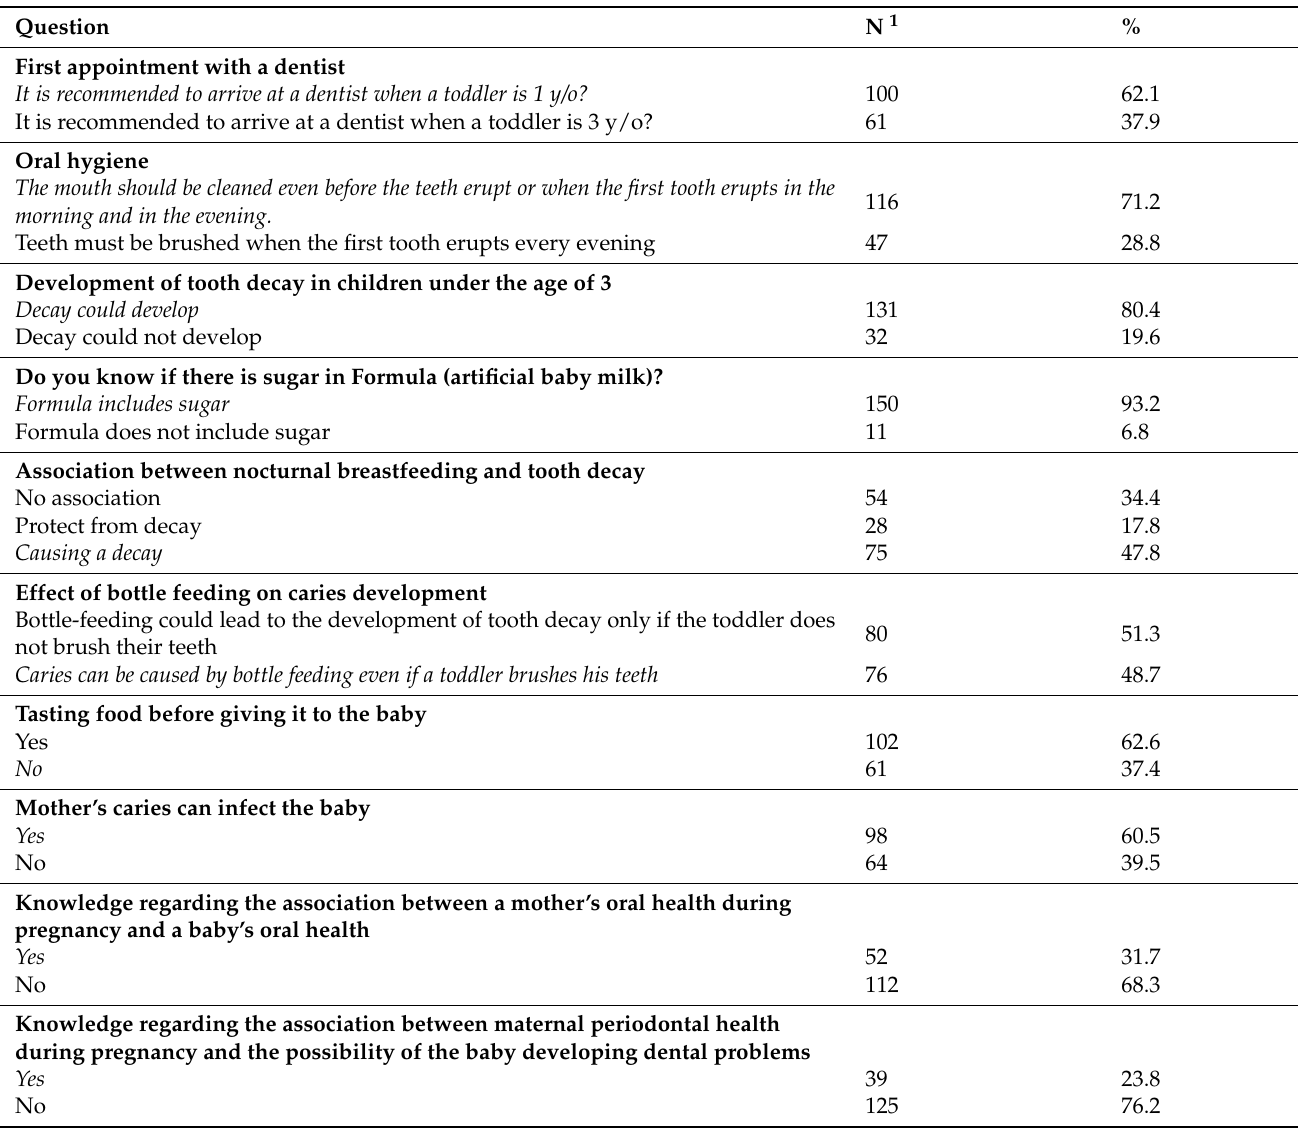
Table 2. Knowledge of breastfeeding mothers about the prevention and health of their toddlers’